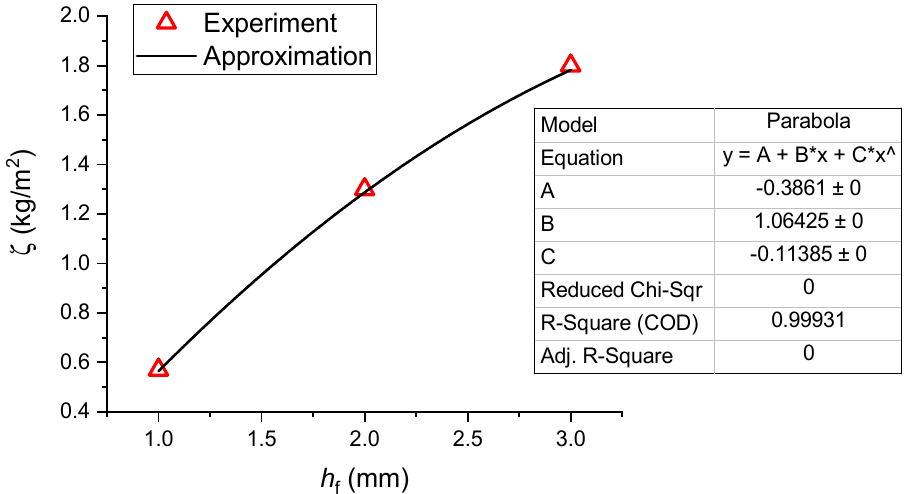
Figure 15. Flame temperature variation dynamics (gasoline, V 0 ≈ 9 mL, d f ≈ 65 mm, S f ≈ 33 cm 2 ) of laboratory-scale fires suppressed by CO 2 hydrate powder with varying thickness of the fuel film (layer).